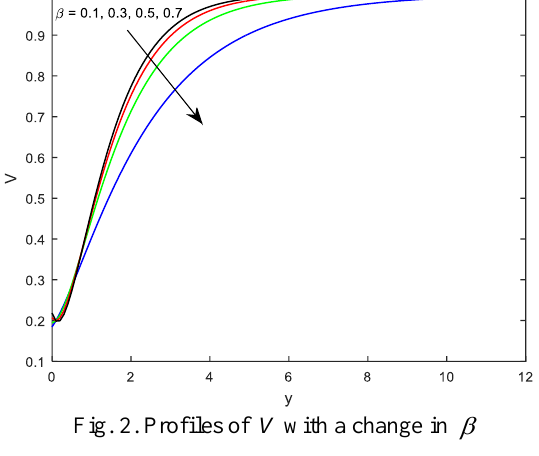
Fig. 2. Profiles of V with a change in 